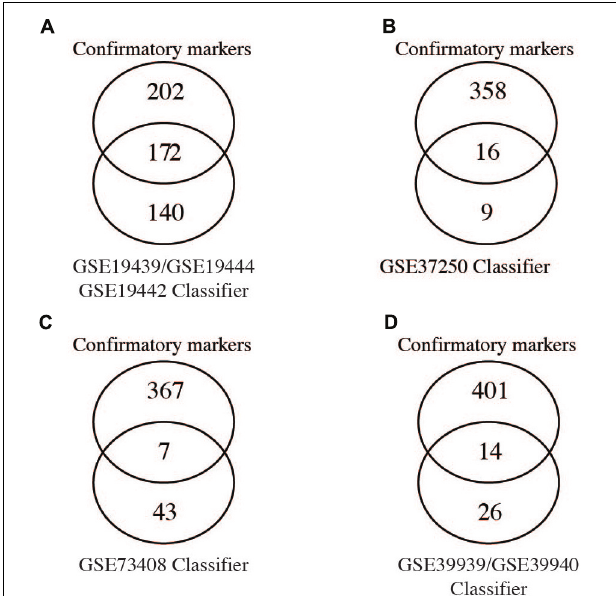
FIGURE 3 | Comparison of meta-analysis to identified gene signatures. Genes significantly differentially regulated (fold change > 1.5) from the meta-analysis were compared to gene signatures identified by different studies as shown. (A–C) Comparison of individual diagnostics signature markers to genes from meta-analysis of adult active TB versus LTBI. (D) Comparison of the childhood TB signatures to childhood active TB versus